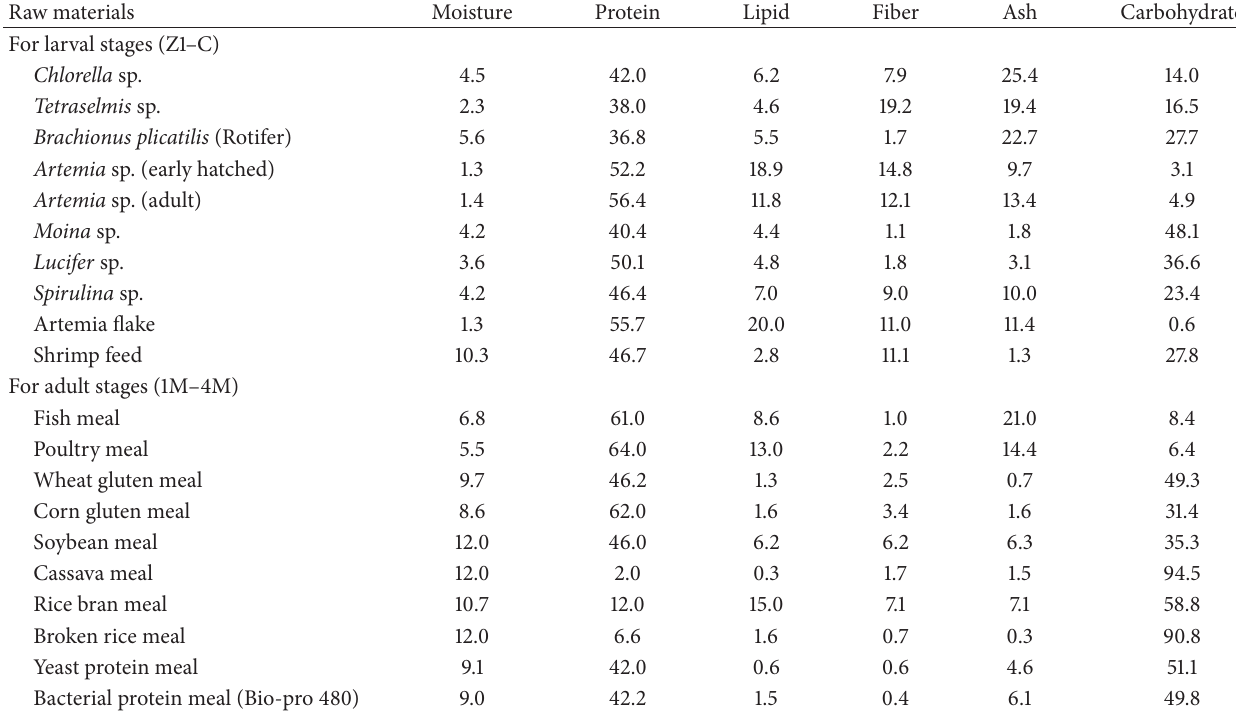
Table 1: Biochemical composition (%) of feed raw materials for in vitro protein digestibility studies. Raw materials Moisture Protein Lipid Fiber Ash